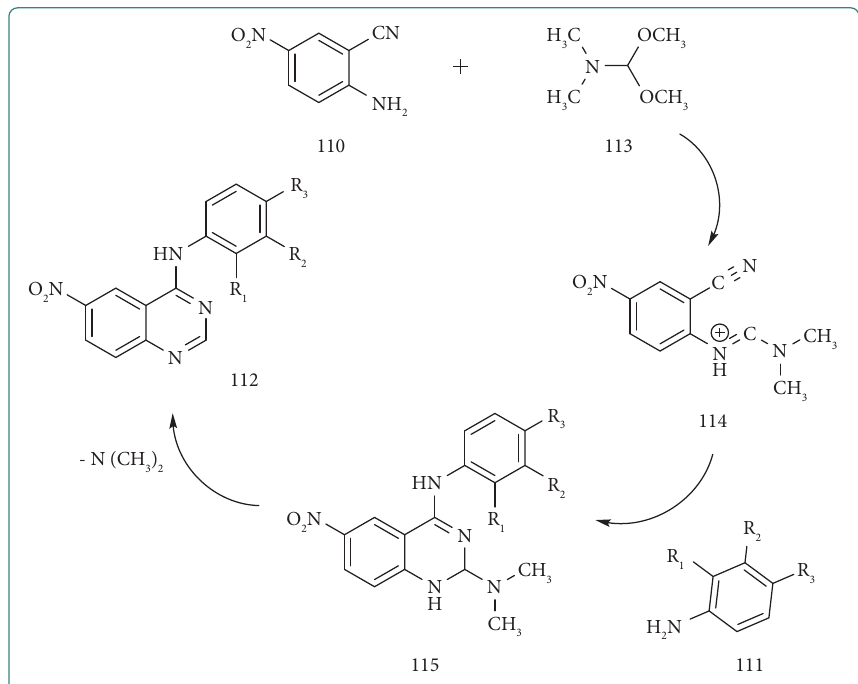
Figure 13: Te proposed mechanism for the synthesis of 4-aminoquinazoline derivatives using 2-amino-5-nitrobenzonitrile under mi- crowave irradiation.